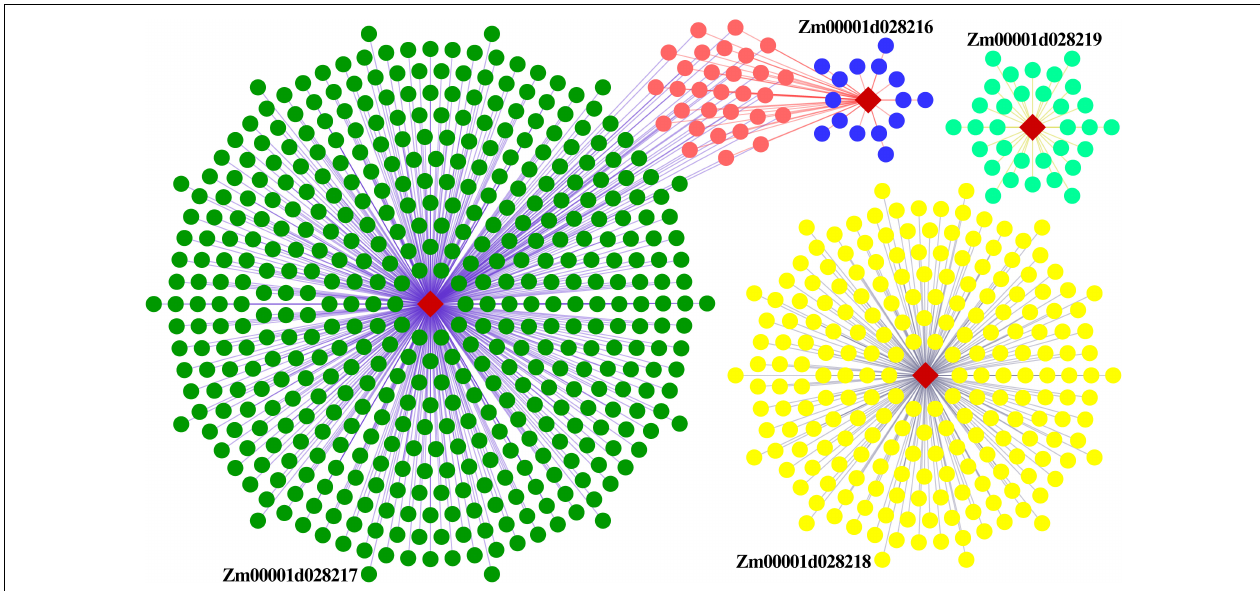
FIGURE 8 | Regulatory co-expression network of key genes related to EL and FL. Weighted gene co-expression gene network of multiple maize tissues, visualized using an organic layout in cytoscape. The nodes in the network were obtained by coloring each gene by its specific expression profile along maize tissues development. Different genes and their interactive genes were marked with different color. Of which, blue nodes represent weight value more than 0.5, orange nodes represent common interactive genes of Zm00001d028216 and Zm00001d028217 .